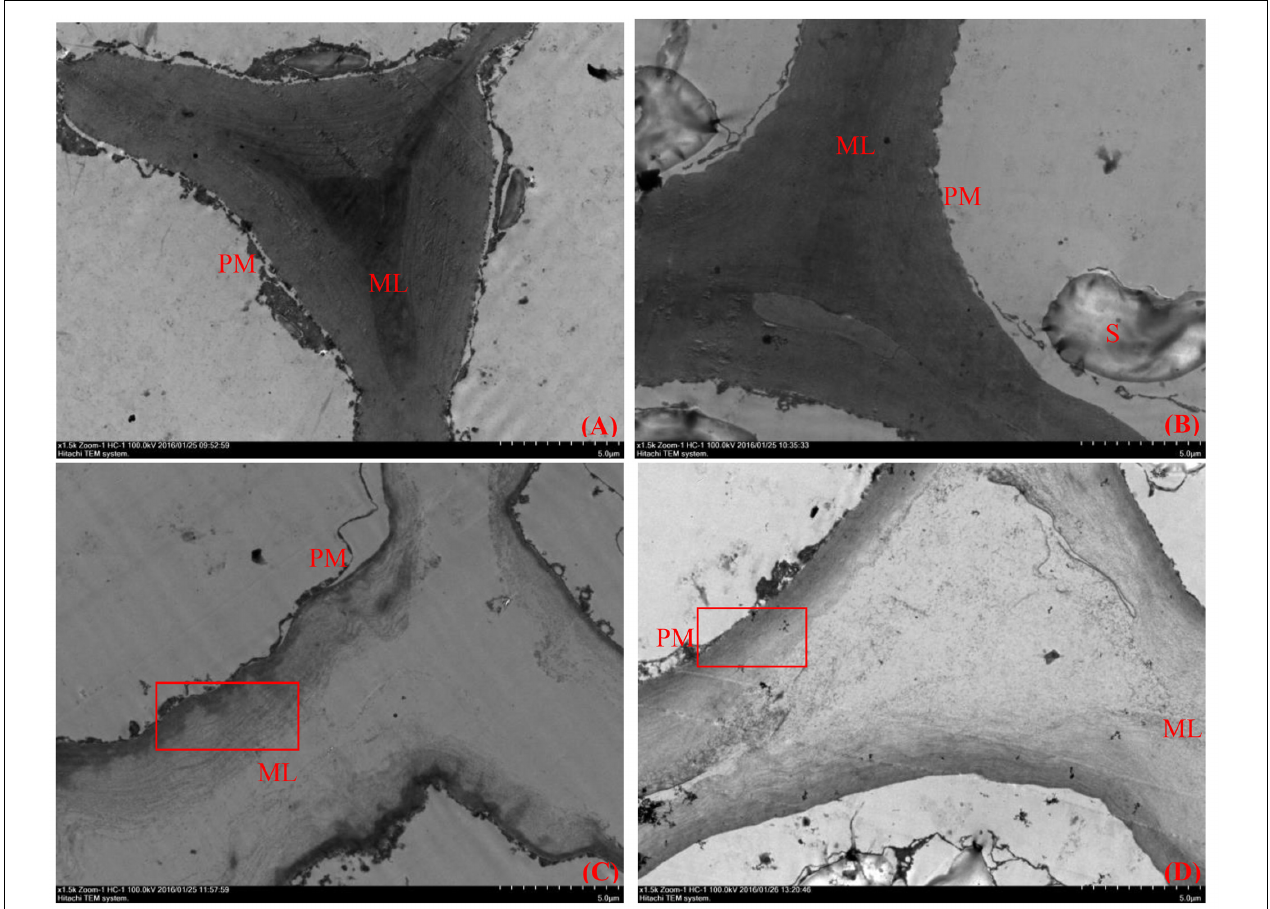
FIGURE 2 | Changes in the ultramicroscopic structure of cell walls in hawthorn fruits at different fruit developmental stages. (A) The middle developmental stage of ‘Ruanrou Shanlihong 3 Hao’ fruits; (B) the middle developmental stage of ‘Qiu JinXing’ fruits; (C) the late developmental stage of ‘Ruanrou Shanlihong 3 Hao’ fruits; (D) the late developmental stage of ‘Qiu JinXing’ fruits. ML, middle lamella; PM, cell membrane; S, starch